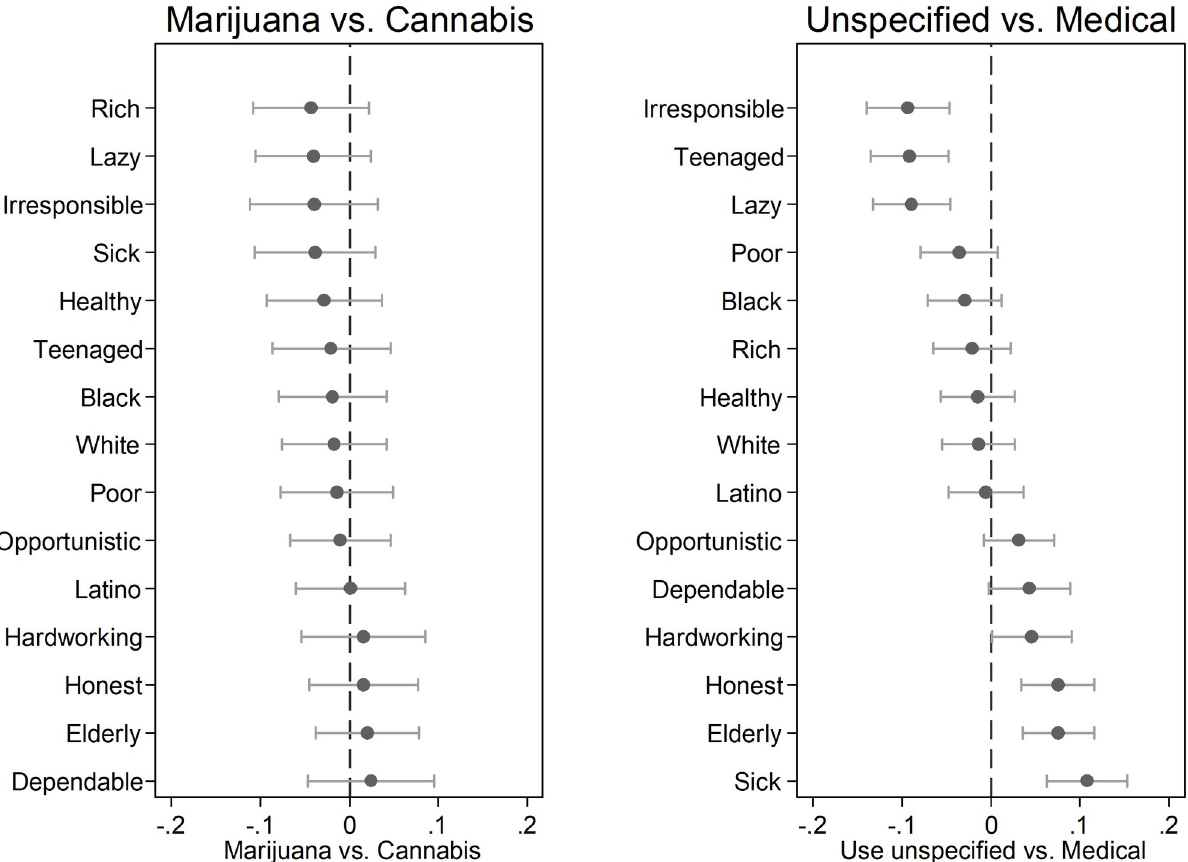
Fig 5. Traits of users, regression coefficients and confidence intervals. OLS regression coefficients with 95% confidence intervals. Survey weights applied. Marijuana vs. Cannabis comparison reflects unspecified use. Unspecified vs. Medical comparison aggregates marijuana with cannabis in each use